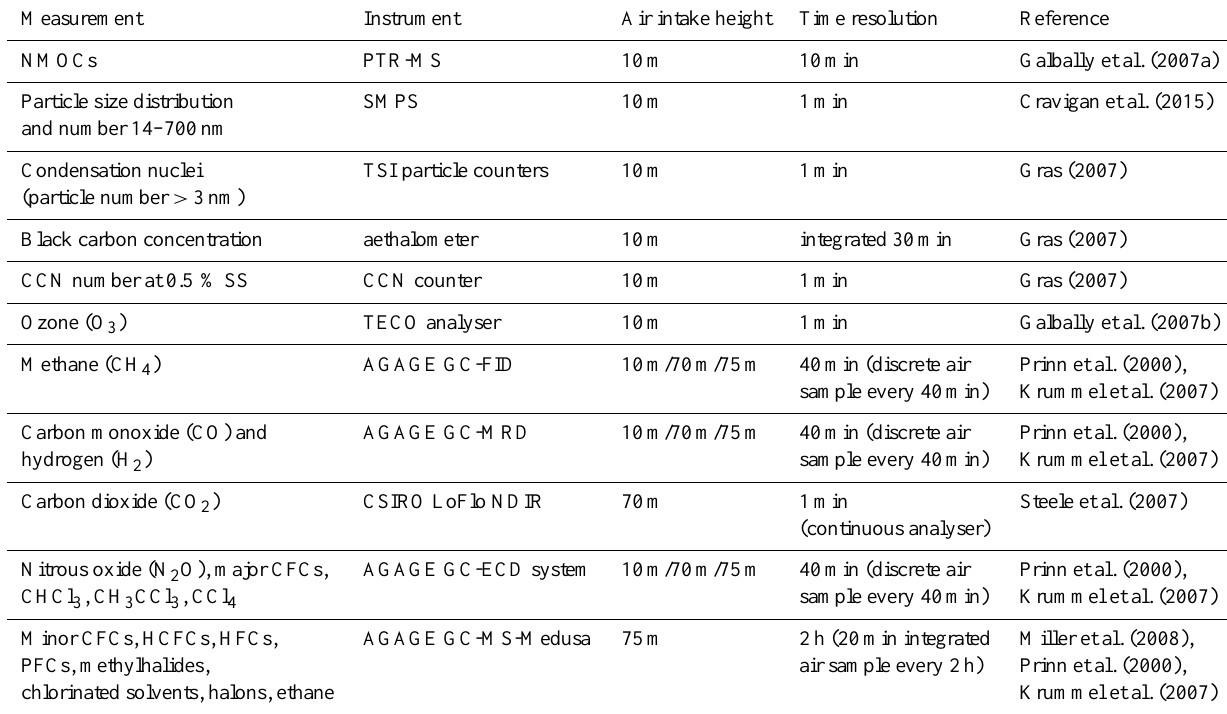
Table 1. Measurement